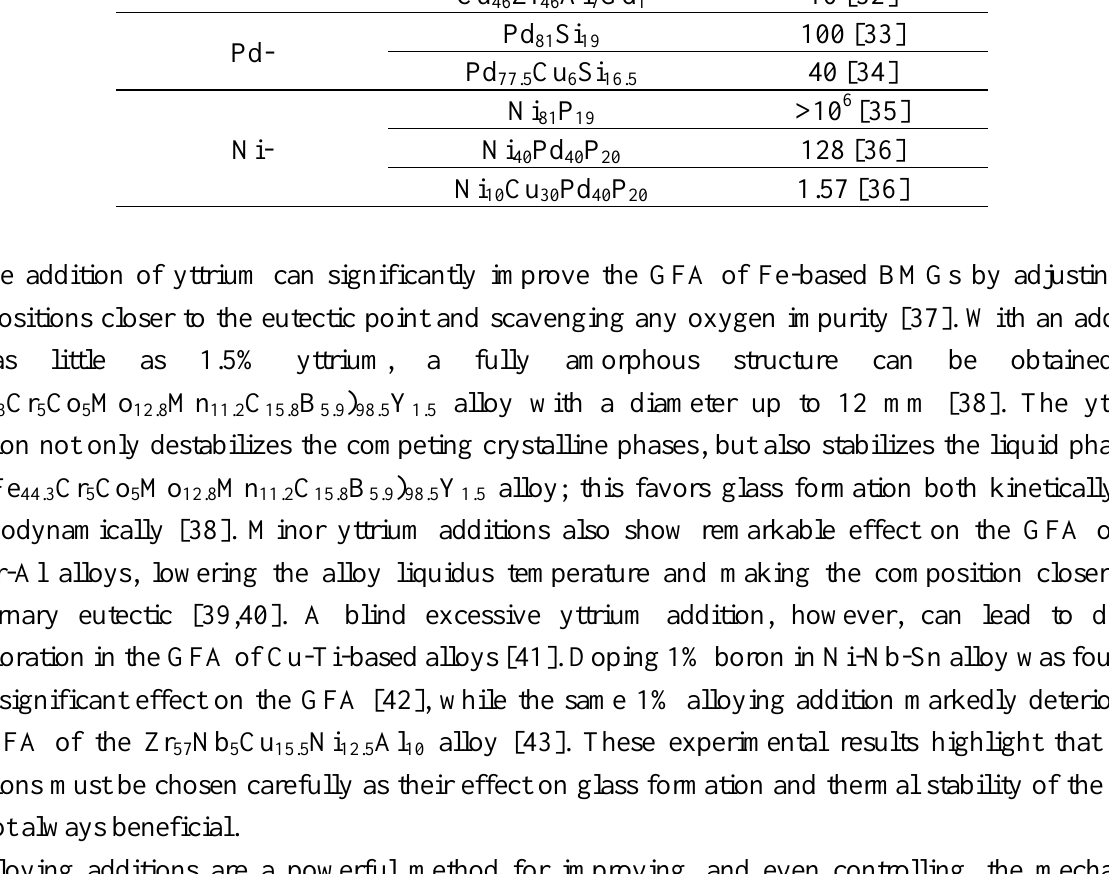
Table 1. The critical cooling rate R